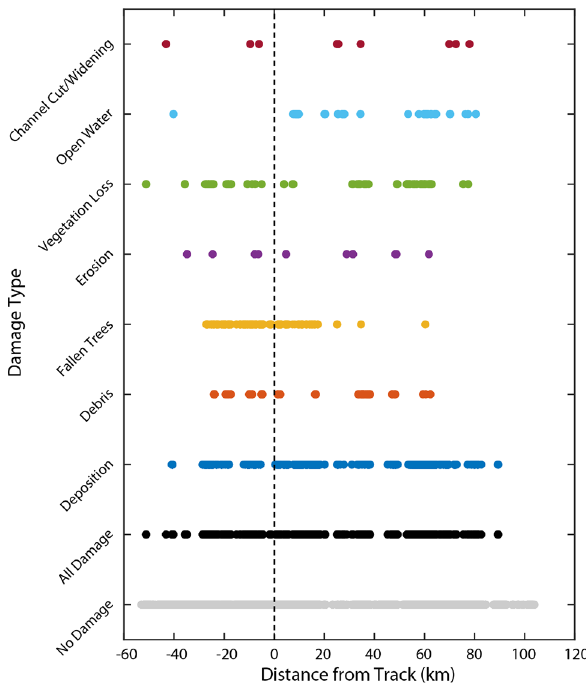
Figure 4. Marsh damage by damage type and distance from the track of Hurricane Michael. The track of the storm is indicated by the dashed line. Negative values indicate points to the west of the track; positive values indicate points to the east of the